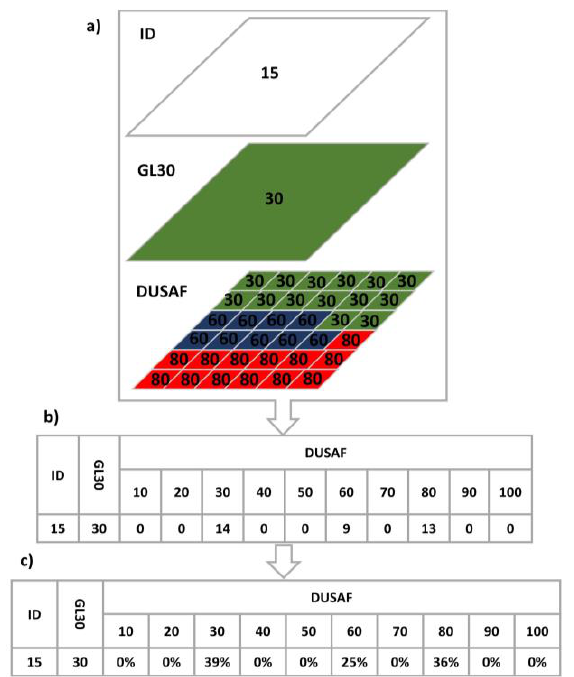
Figure 1. Schematic of the data overlay procedure to compute sub-pixel error on a sample target map pixel i=15